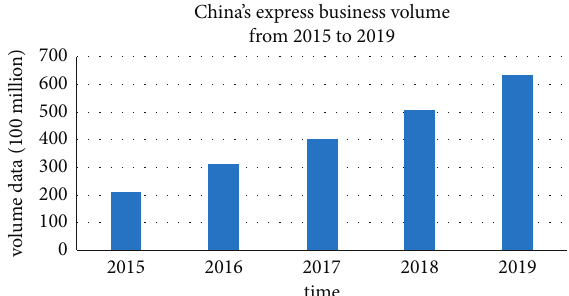
Figure 1: The data of China’s express business volume from 2015 to